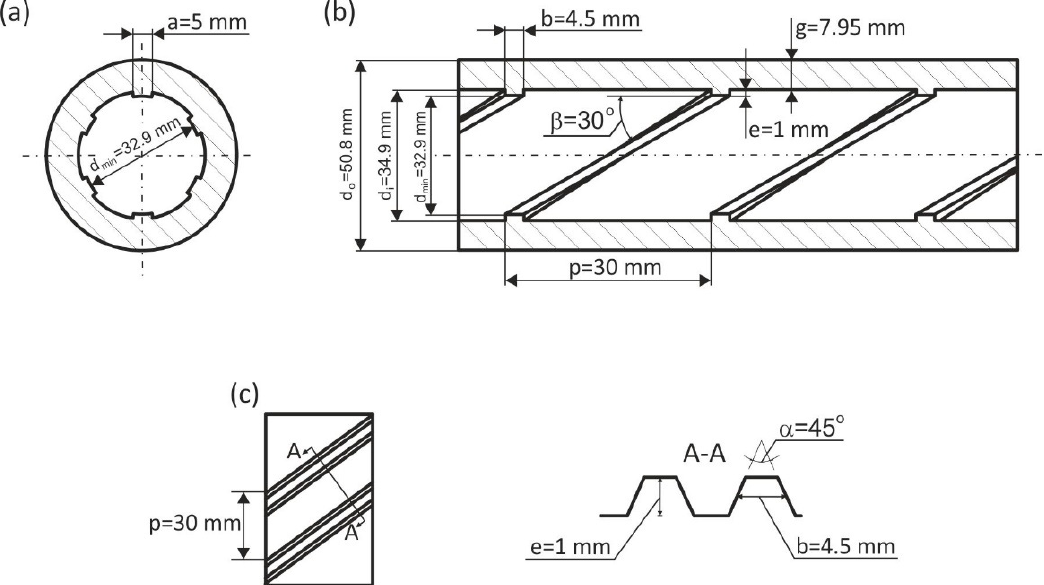
Figure 3. Geometrical characteristics of the tested tube: ( a ) transverse section, ( b ) longitudinal section, ( c ) rib detail.